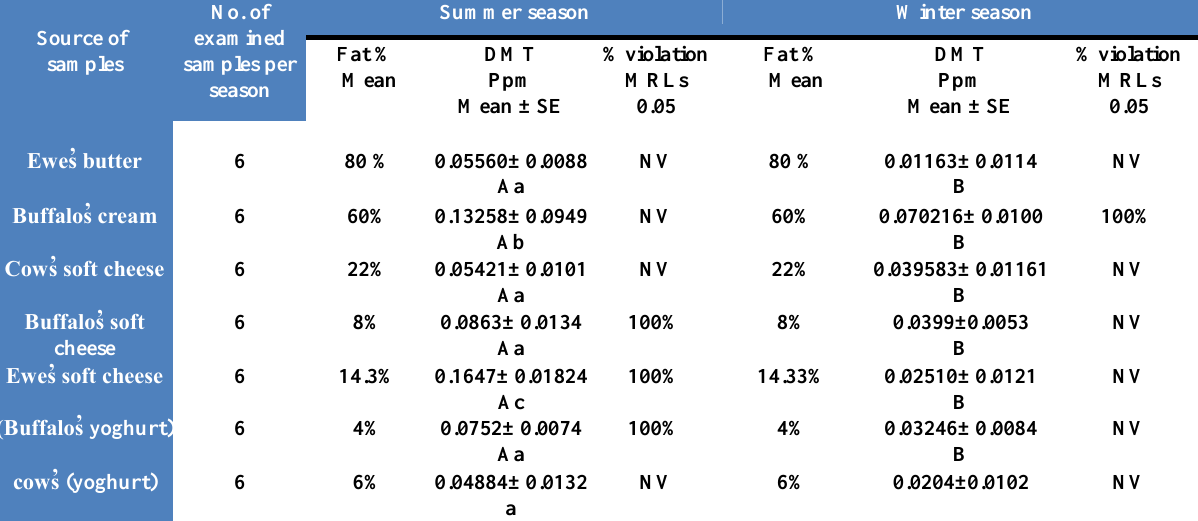
Table, 4: Seasonal variation of the mean levels of DTM residues in the locally produced butter, cream, soft cheese and yoghurt collected from three different